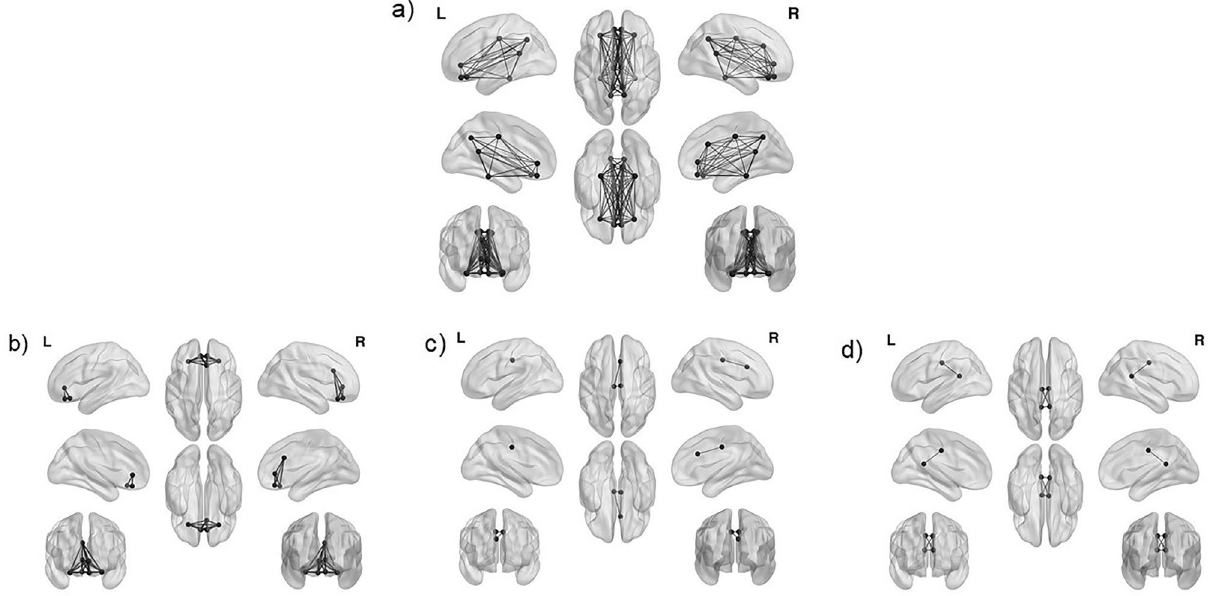
Figure 3. Analyzed subsystems of the Default Mode Network (DMN). ( a ) All 15 regions of interest of the DMN, ( b ) 7 regions of interest of the anterior DMN, ( c ) 3 regions of interest for the core DMN ( d ) 4 regions of interest for posterior DMN. The brain networks were visualized with BrainNet Viewer 69